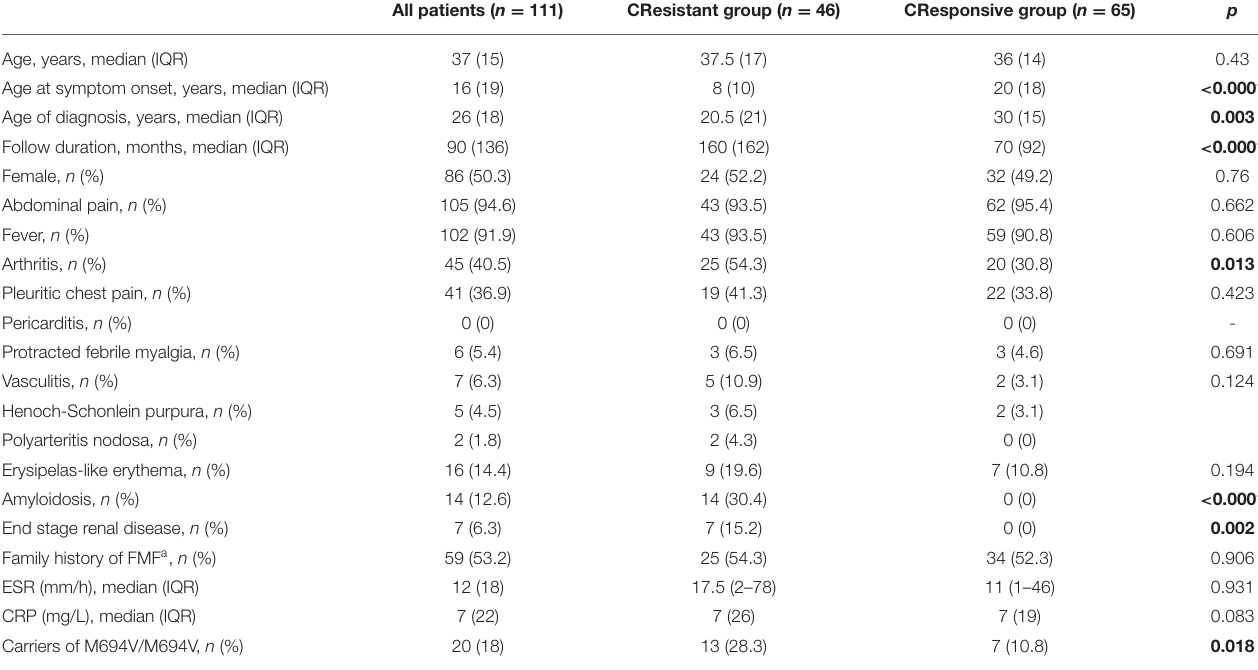
TABLE 1 | The demographics and clinical characteristics of familial Mediterranean fever patients. All patients ( n = 111) CResistant group ( n = 46) CResponsive group ( n =